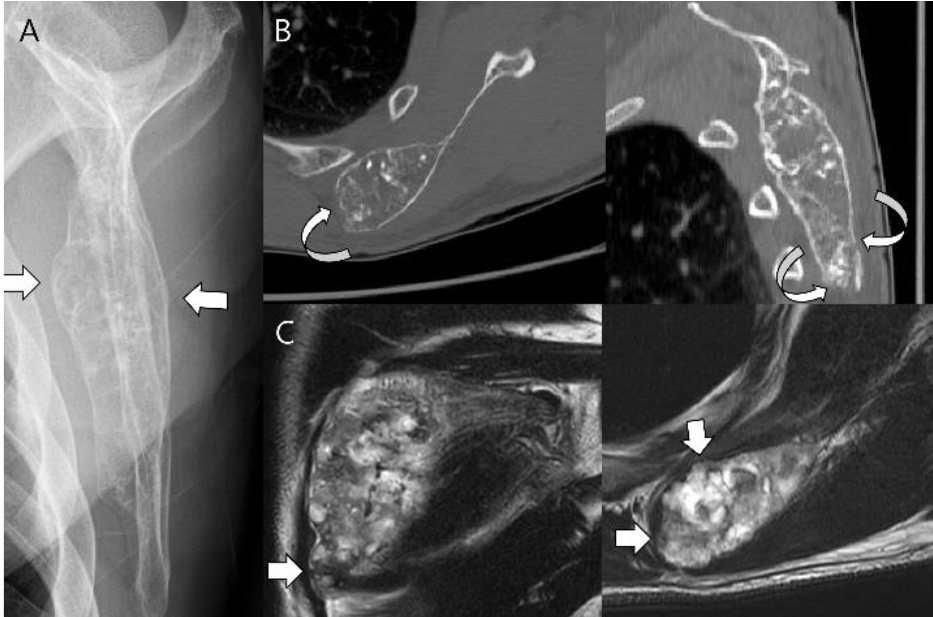
Figure 18. Chondrosarcoma grade 2 of the scapula in a 58-year-old man. ( A ) Plain radiograph shows a lobulated intramedullary mass with chondral-type mineralization and bone expansion (arrows) in the scapular body. ( B ) Axial and sagittal CT scans show a large intramedullary mass with cortical destruction (curved arrows). ( C ) Coronal and axial T2-weighted images show focal extraosseous soft tissue masses (arrows).